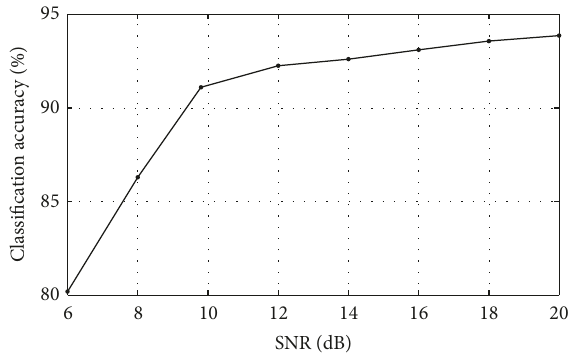
Figure 4: Classification accuracies for different SNR.